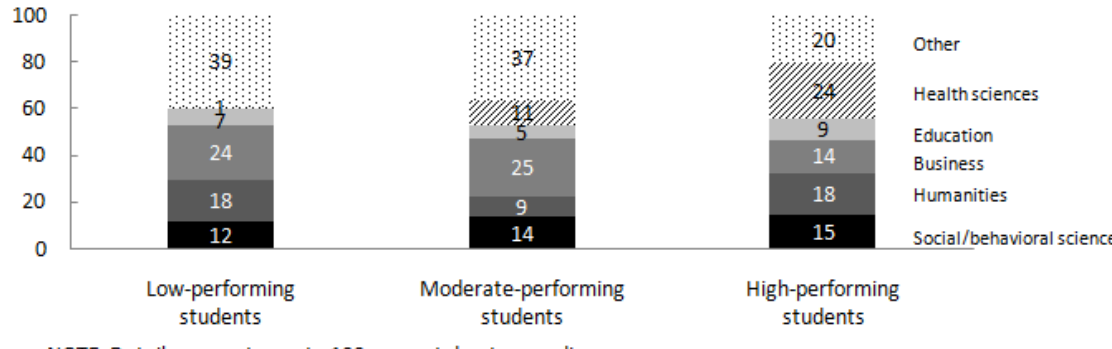
Figure 5. Last major feld reported by STEM entrants who switched